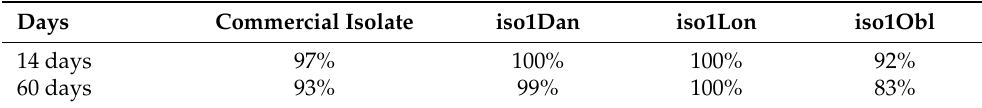
Table 5. Percentage of G. mellonella larvae killed by nematodes of different EPN isolates after 14 or 60 days in the